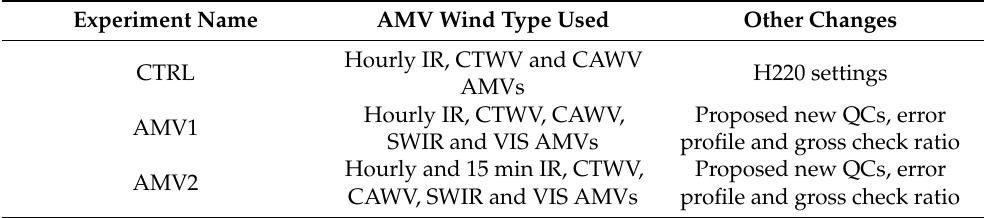
Table 2. List of assimilation experiments conducted.